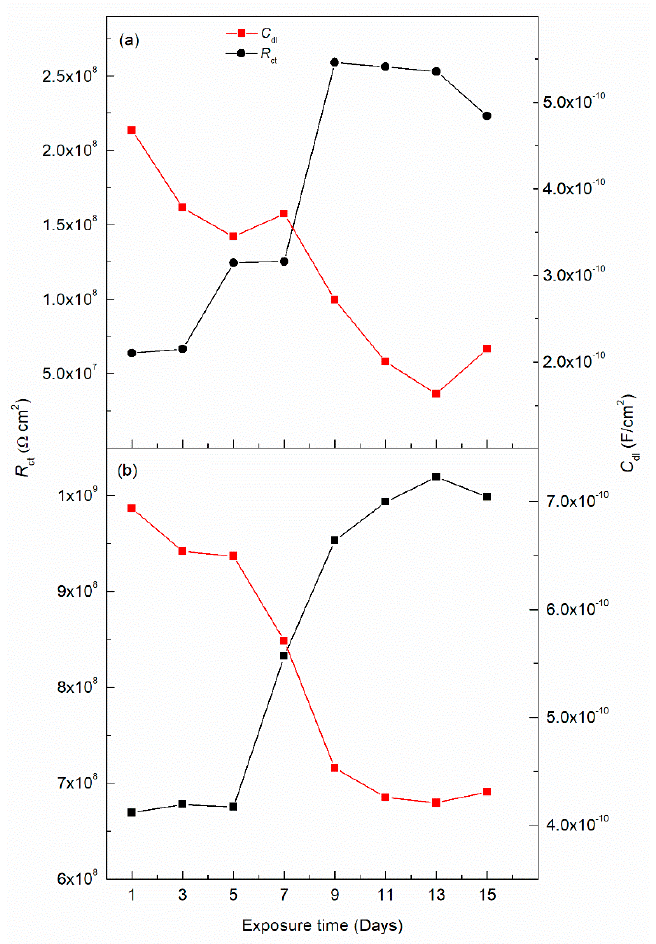
Figure 6. The resistance and capacitance monitoring of specimens ( a ) without microcapsules, and ( b ) with microcapsules in 3.5 wt.% NaCl measured by EIS.